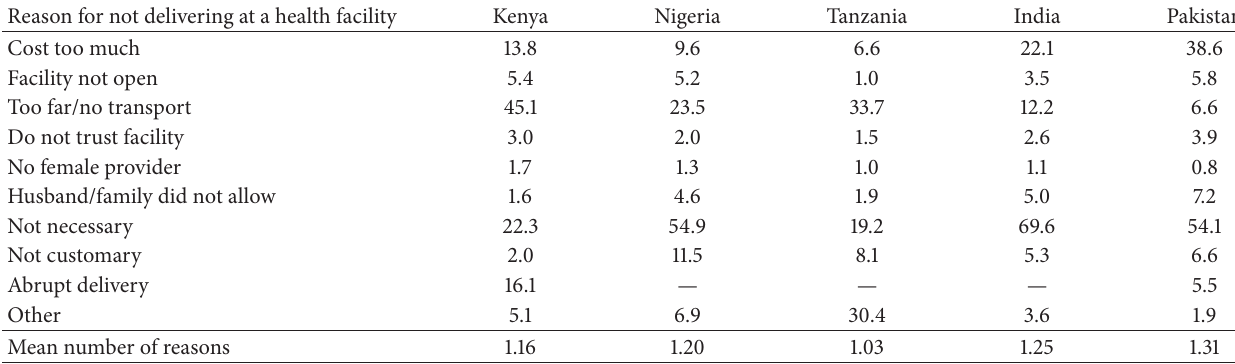
Table 4: Percent citing each reason for not delivering at a health facility by country.